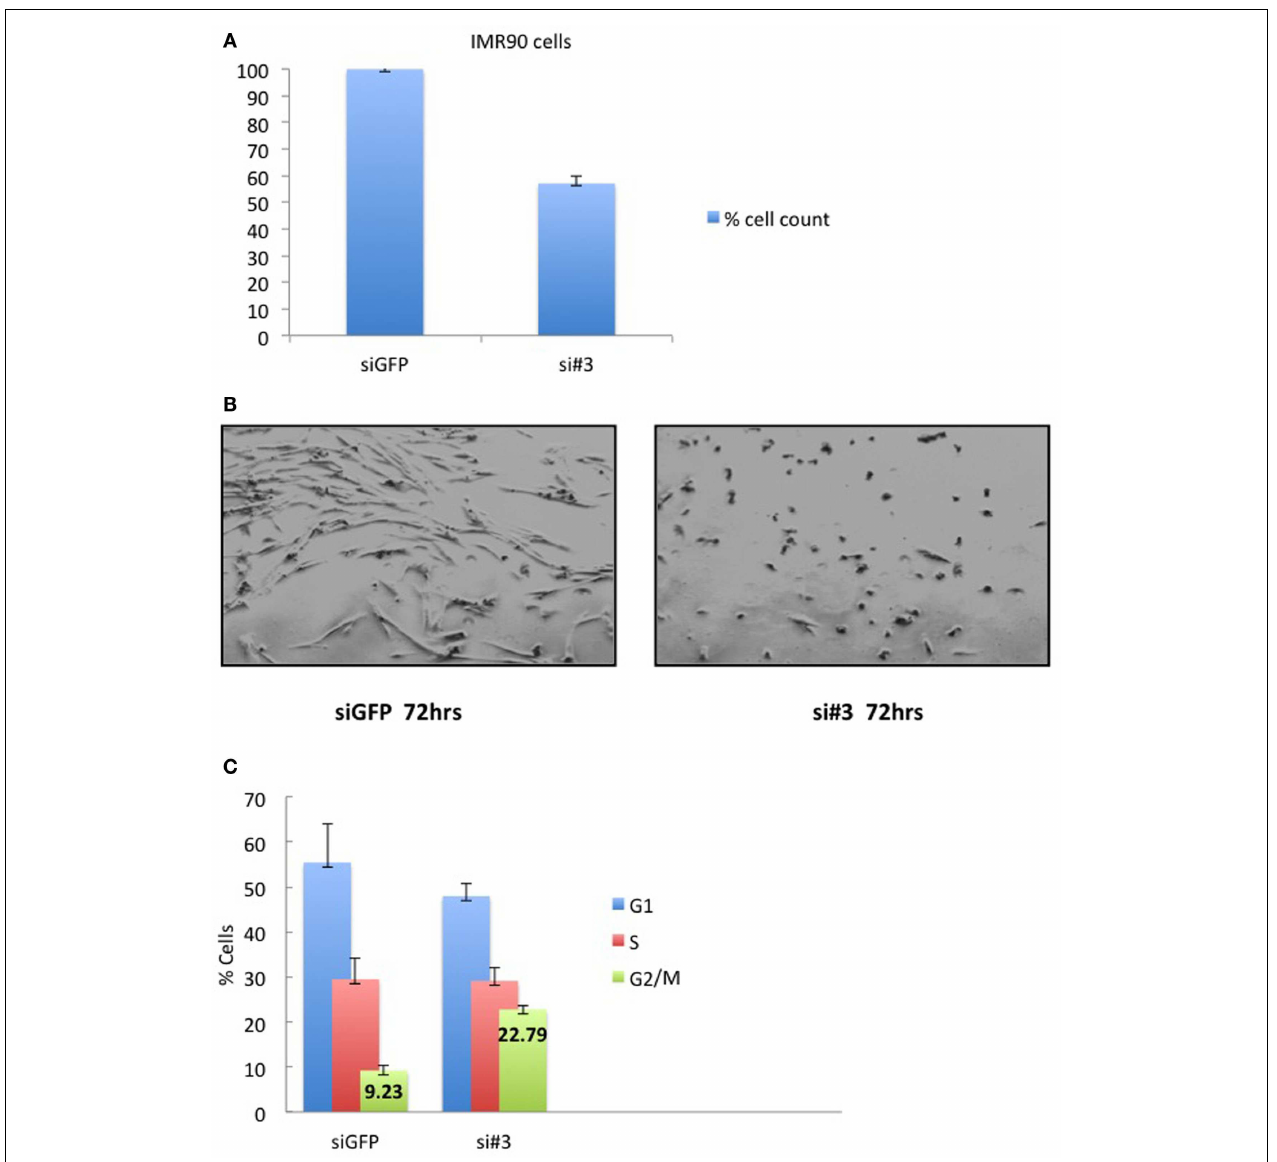
72h after transfection. (C) Cell cycle profiles of cells processed as in (B) , with% of cells in G2/M indicated as averages of three independent